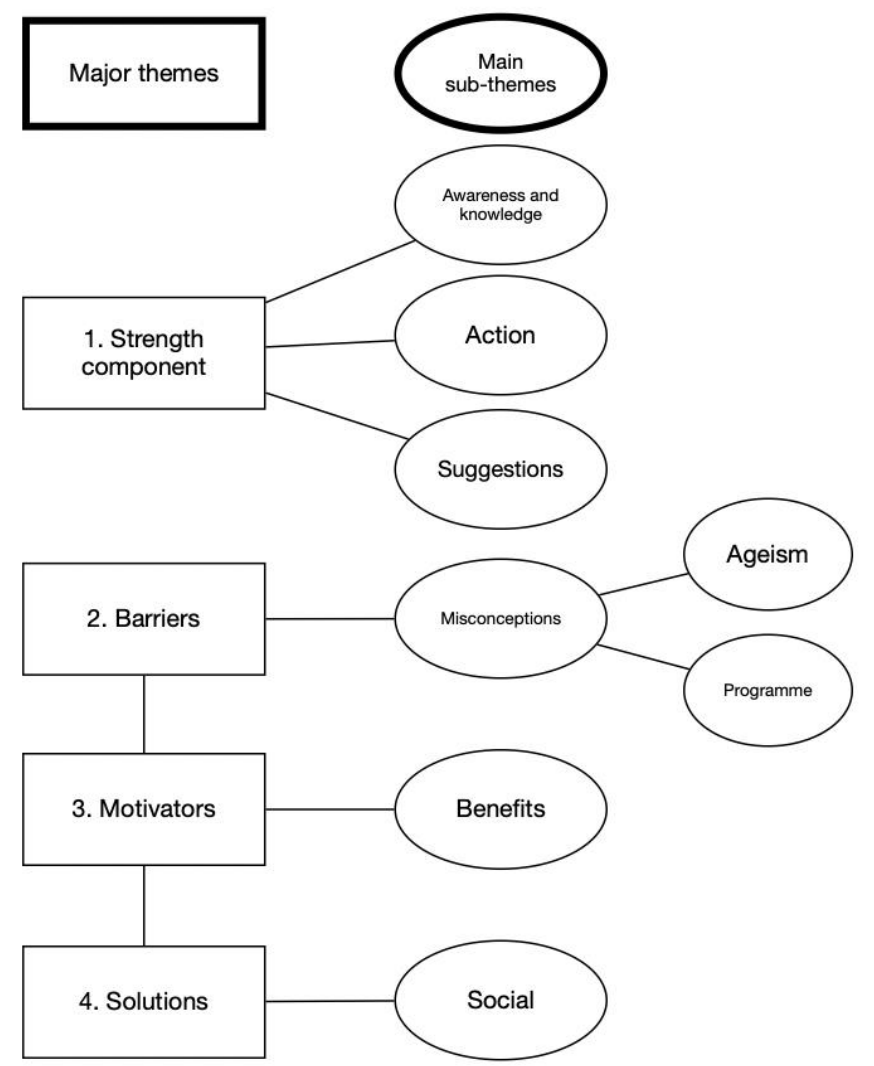
Figure 2. Coding Tree. A total of four major themes were present in the data.